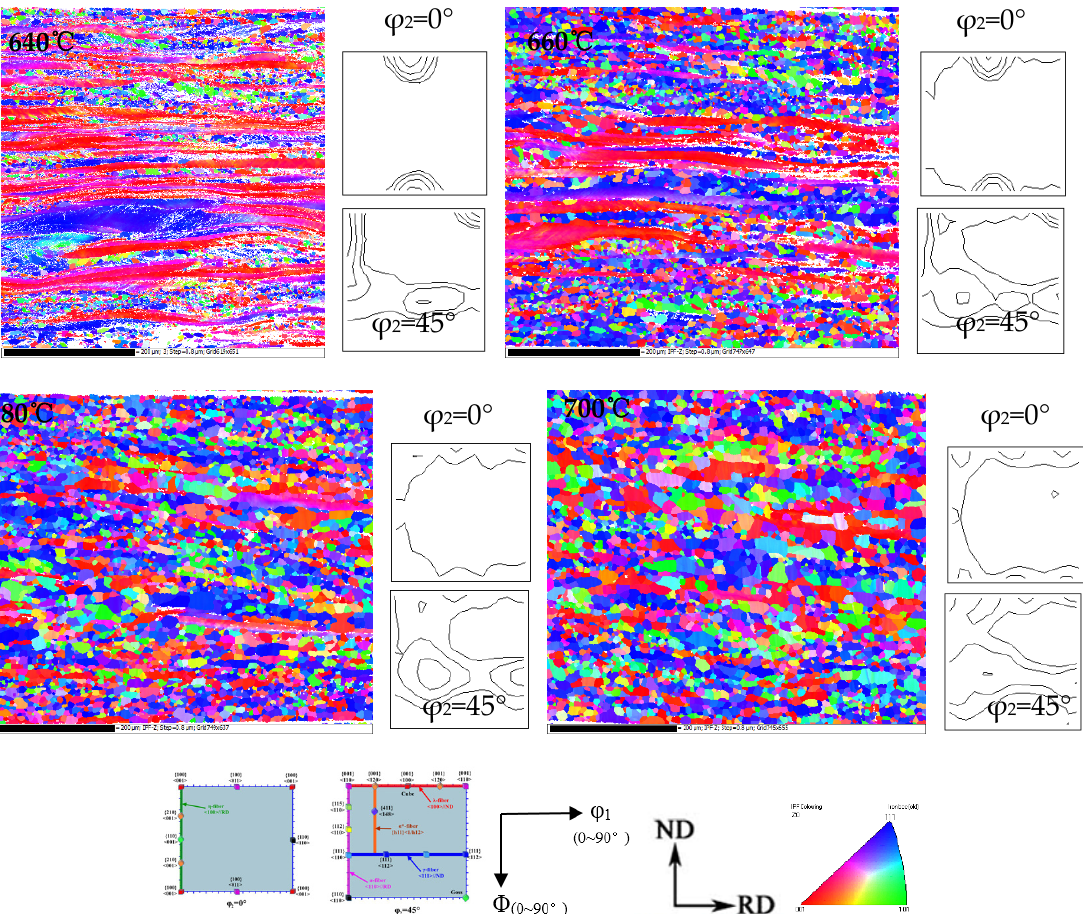
Figure 6. EBSD inverse pole figure (IPF) maps, φ 2 = 0° and φ 2 = 45° ODF of Fe-0.65%Si non-oriented electrical steel in the recrystallization process ( levels: 1,2,4,8; deviation angle 15°).